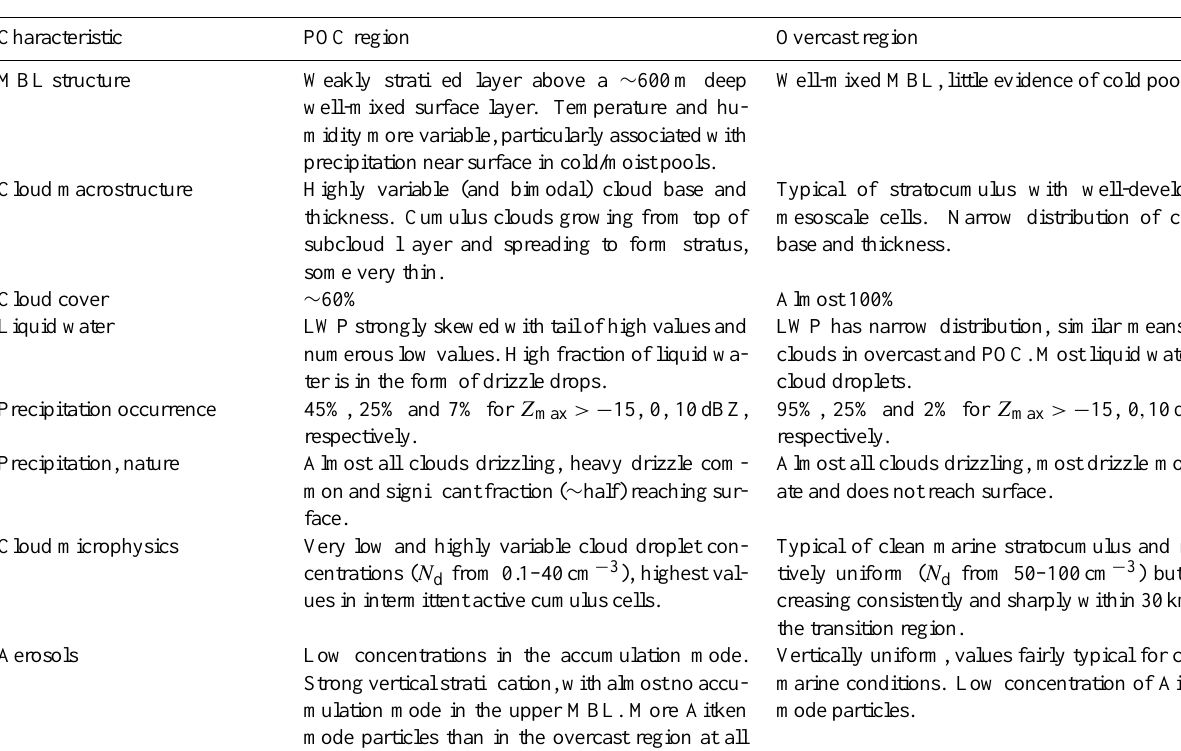
Table 2. Key characteristics of the MBL, cloud, precipitation, and aerosol structure in the POC and the overcast region. Characteristic POC region Overcast region Well-mixed MBL, little evidence of cold pools. MBL structure Weakly stratified layer above a ∼ 600m deep well-mixed surface layer. Temperature and hu- midity more variable, particularly associated with precipitation near surface in cold/moist pools. Typical of stratocumulus with well-developed Highly variable (and bimodal) cloud base and mesoscale cells. Narrow distribution of cloud thickness. Cumulus clouds growing from top of base and subcloud l ayer and spreading to form stratus,